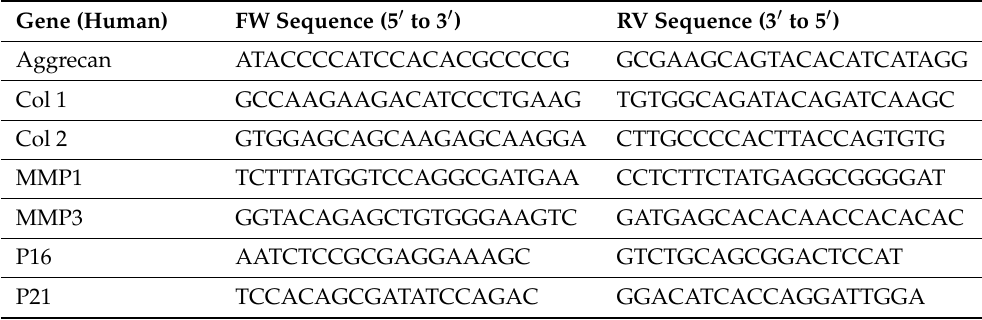
Table 1. qRT-PCR primers used for quantifying genes involved in senescence and matrix anabolism and catabolism. Forward (FW) and reverse (RV) sequences for human PCR primer genes used in qRT-PCR assays for matrix proteins, matrix catabolic proteins, and cellular senescence markers. A, T, C, and G letters in sequences represent base